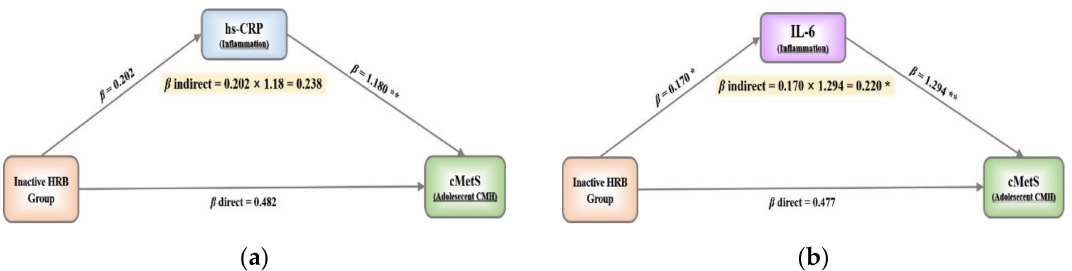
Figure 3. The effect of mediators (M) on the association between health-related behaviors group (X) and continuous metabolic syndrome score (Y): ( a , hs-CRP) considering hs-CRP as mediators; ( b , IL-6) considering IL-6 as mediators. * p < 0.05, ** p < 0.01. HRB, health-related behavior; hs-CRP, high-sensitivity C-reactive protein; IL-6, interleukin-6; cMetS, continuous metabolic syndrome score; CMH, Cardiometabolic health. All models were adjusted by sex, age, and monthly household